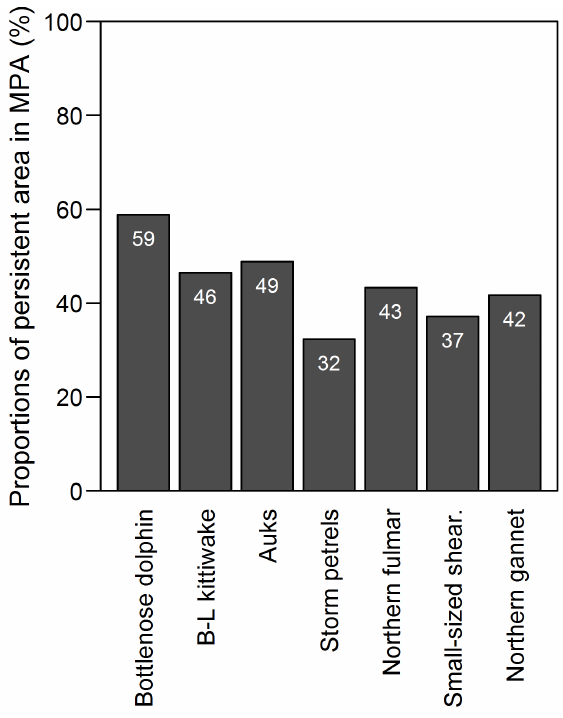
Figure 6 – Proportions of persistent areas (cells included in core areas more than 50% of the studied years) encompassed within existing MPAs (Marine Natural Parks and Bird Di- rective sites for seabirds; Marine Natural Parks and Habitat Directive sites for bottlenose dolphins) for the eight studied species, in percent. The proportion is indicated in each